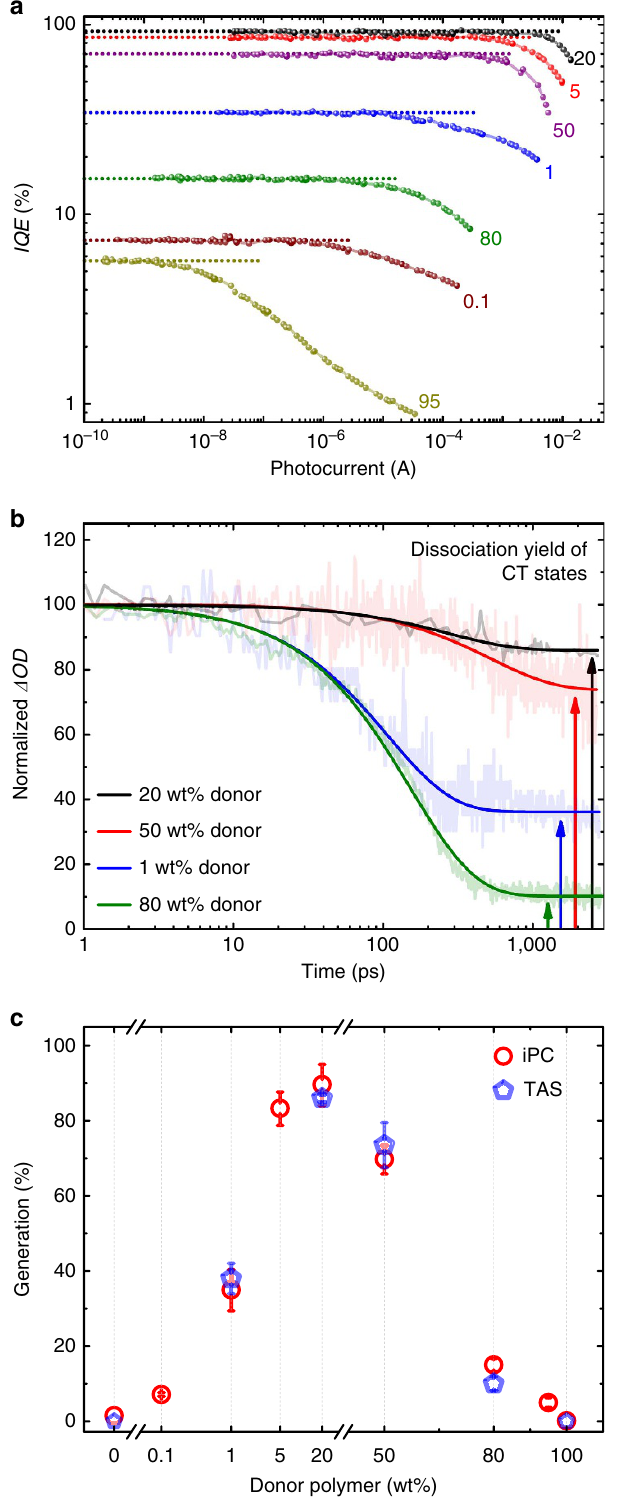
devices, respectively. In contrast, the faster carrier mobility is Figure 1 | Charge-generation yields from iPC and TAS. ( a ) IQEs as a function of the photocurrent of PCDTBT:PC70BM devices with different donor fractions (wt%, marked by the numbers). The constant IQE at low photocurrents (as marked by the dotted lines) before non-geminate recombination causes the downward deviation, is an estimate of the charge-generation yield. ( b ) Normalized transient absorption spectra of the blends monitoring the polymer positive polarons, following excitation at 560nm at a fluence of 500nJcm (cid:2) 2 . Solid lines are single exponential fits, indicating a geminate decay of bound and free charges, which absorb at 1,000nm. The dissociation yield of the CTstates is given by the fraction of charges remaining at long times (as marked by the arrows). ( c ) The generation efficiency of free charges determined from a , b as a function of the donor fraction. iPC error bars are determined from the first s.d. of the constant IQE regime considering two measurements on different pixels and a relative variation of 5% of the active layer absorption. TAS error bars represent the first s.d. of the plateau regime of the transient absorption